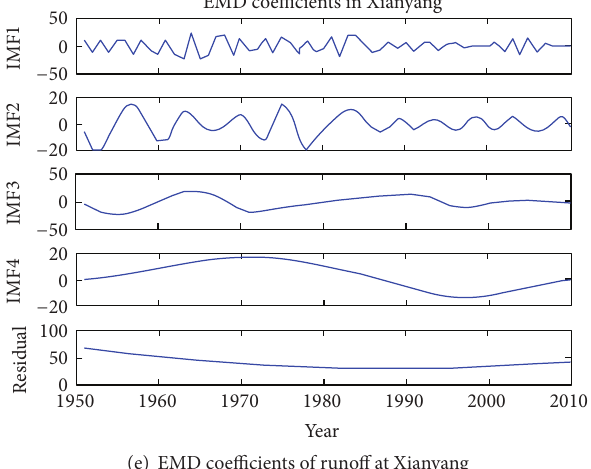
Figure 2: EMD coefficients of runoff at each hydrological